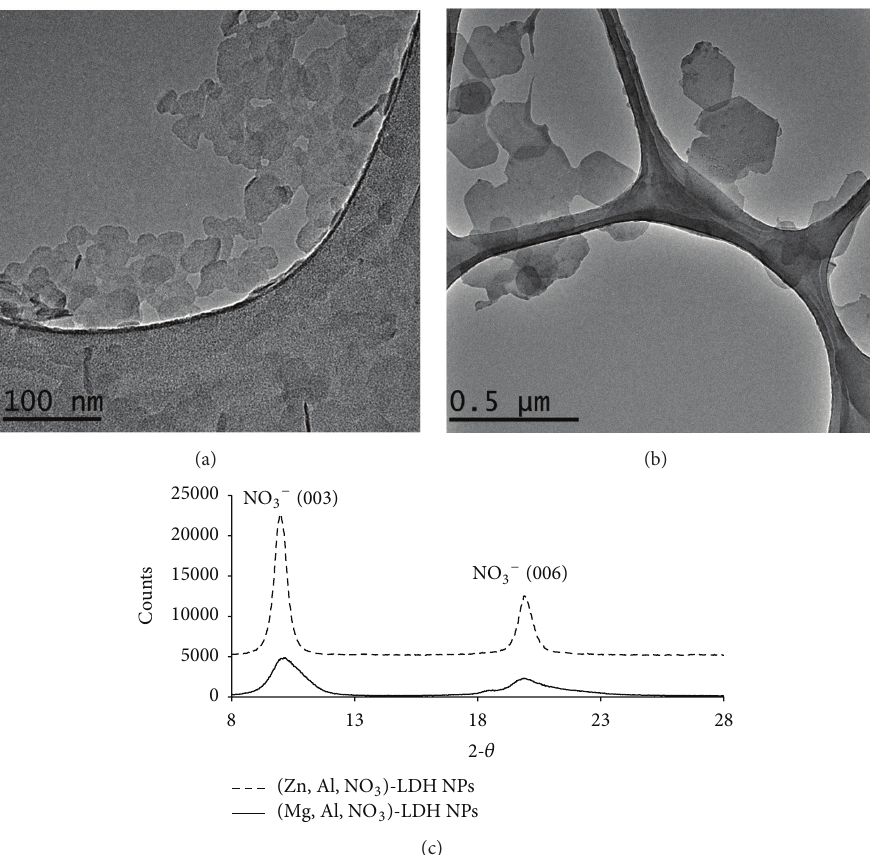
Figure 1: TEM bright field images of (Mg, Al, NO 3 )-LDH nanoparticles and (Zn, Al, NO 3 )-LDH nanoparticles. The X-ray diffraction patterns of the nanoparticles are shown in